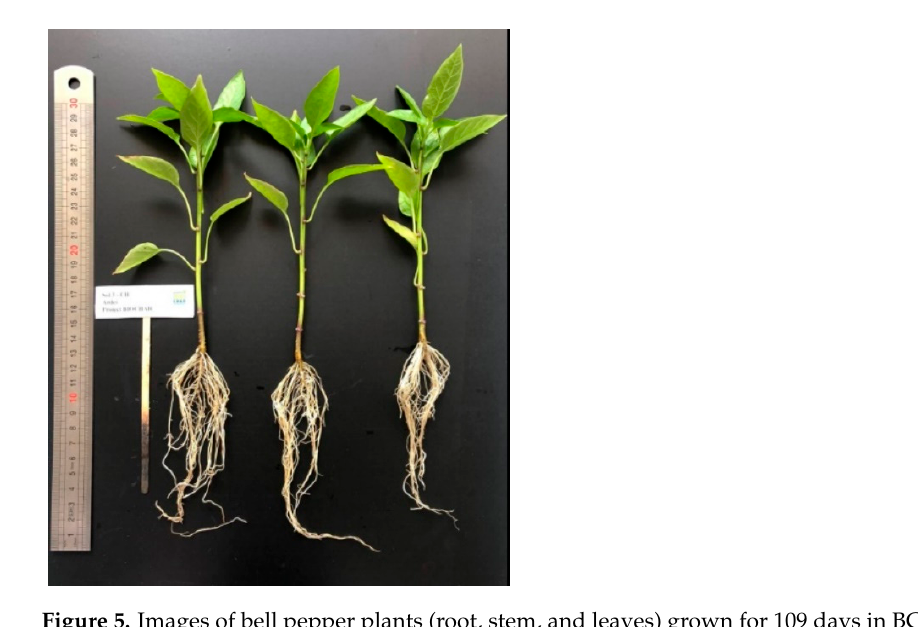
Figure 4. Images of bell pepper plants grown for 109 days in non-amended and BC-amended strongly acidic soil S3 (luvisol), applying different treatments: ( a ) S3; ( b ) S3 + BC; ( c ) S3 + F; ( d ) S3 + BC + F; and ( e ) S3 + BC + F/2; (BC) biochar; (F) and (F/2) foliar fertilizer (0.2 mL/100 mL water and 0.1 mL/100 mL water).